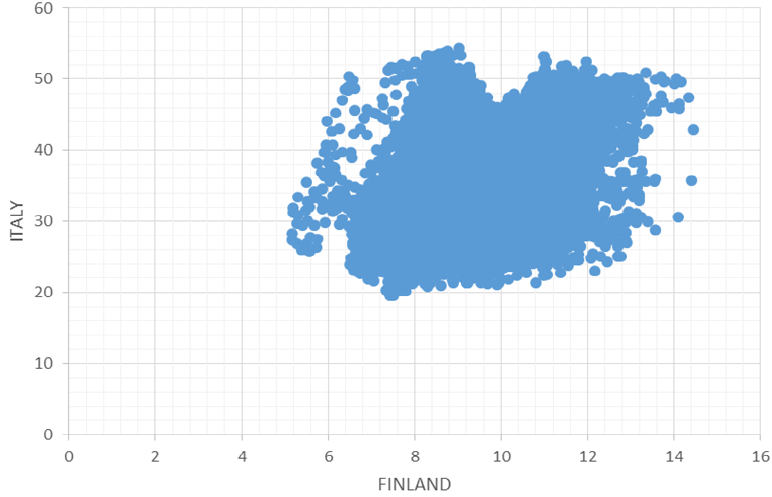
Figure 27. Scatter plot of the electricity demand in Finland and Italy.